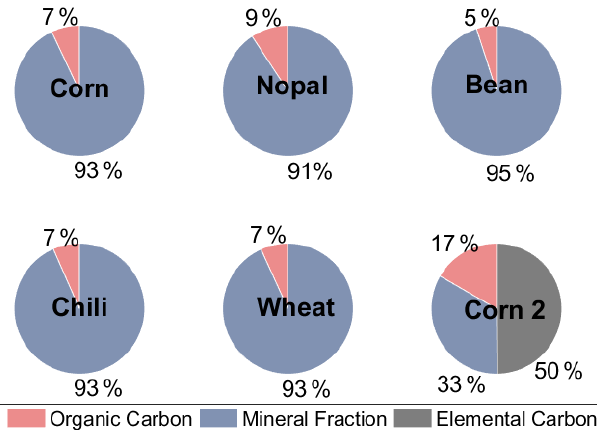
Figure 4. Organic carbon, elemental carbon, and mineral contribu- tions to the aerosol samples generated in the